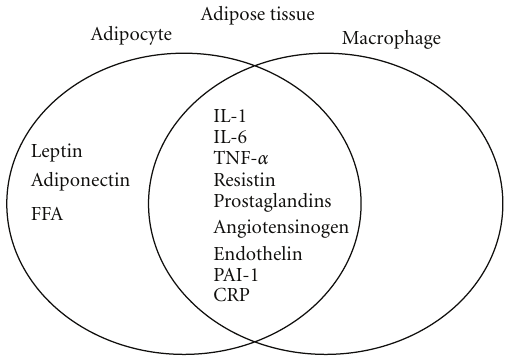
Figure 1: Cytokines secreted by adipocytes and/or macrophages in human adipose